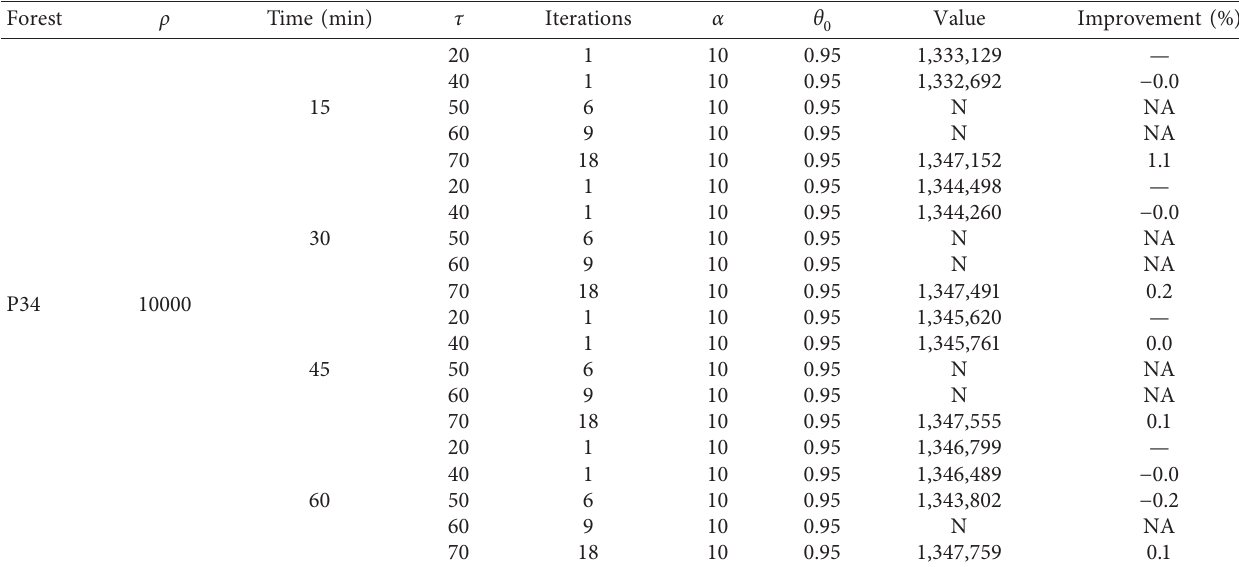
Table 5: Effects of τ and allocated time for the forest